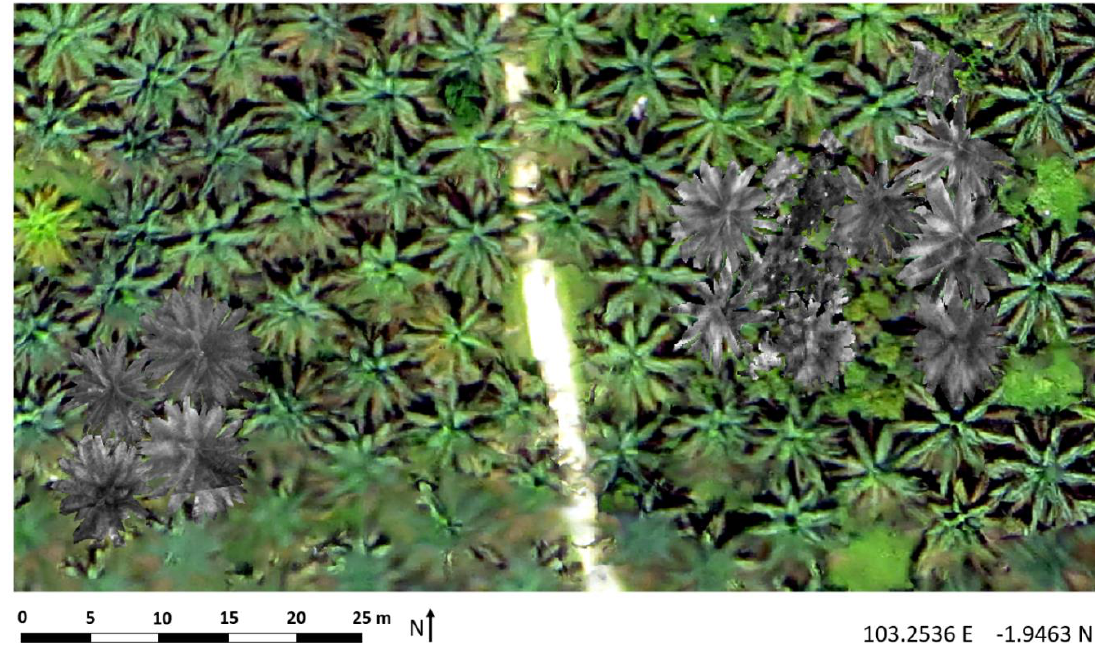
Figure 1. The studied monoculture oil palm plantation on the left-hand side and an exemplary oil palm agroforest site on the right side. Canopies of the measured trees and palms are shown with greyscale thermal images. Canopies were marked with 8-bit barcodes (small white dots in the image) to be recognizable from the air. The map shows an exemplary selection of all sampled canopies.